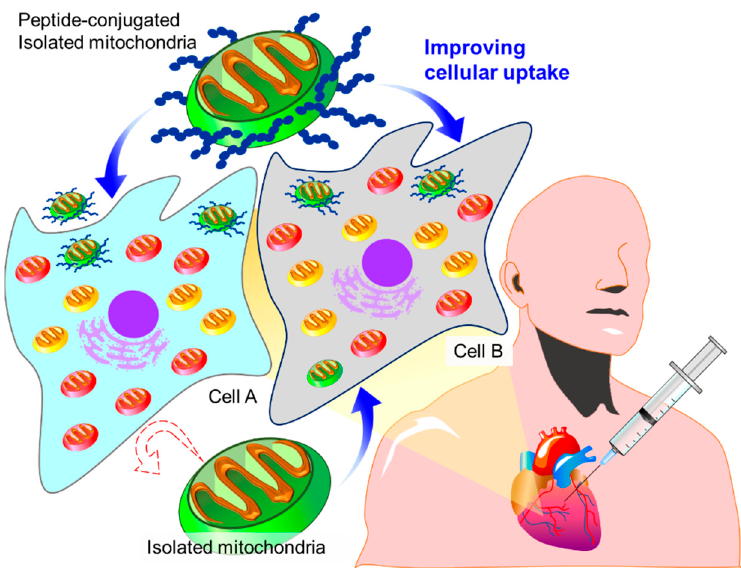
Figure 1. Strategy to improve the cellular uptake of isolated mitochondria. Cellular uptake capacity of isolated mitochondria is low and not taken up by a certain cell. Peptides such as a cell-penetrating peptide improve the cellular uptake of the isolated mitochondria.